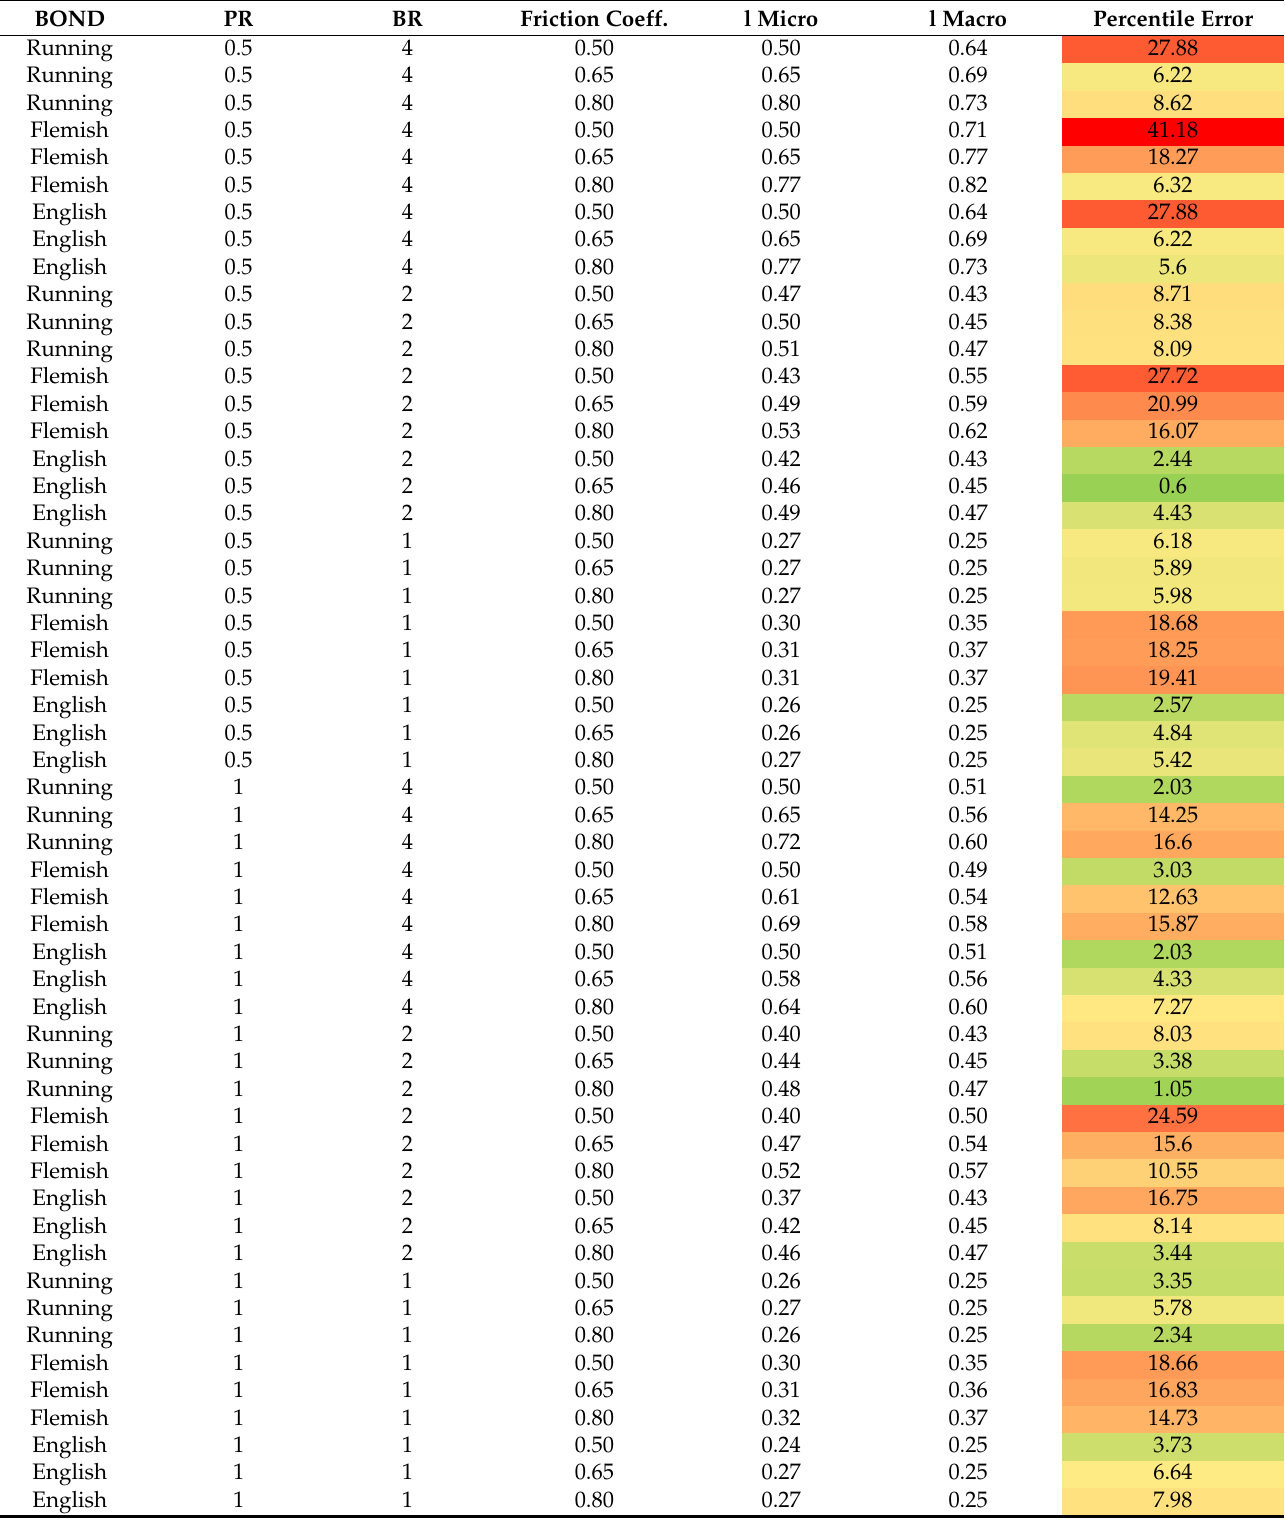
Table A10. Comparison of Macro and Micro Load multiplier